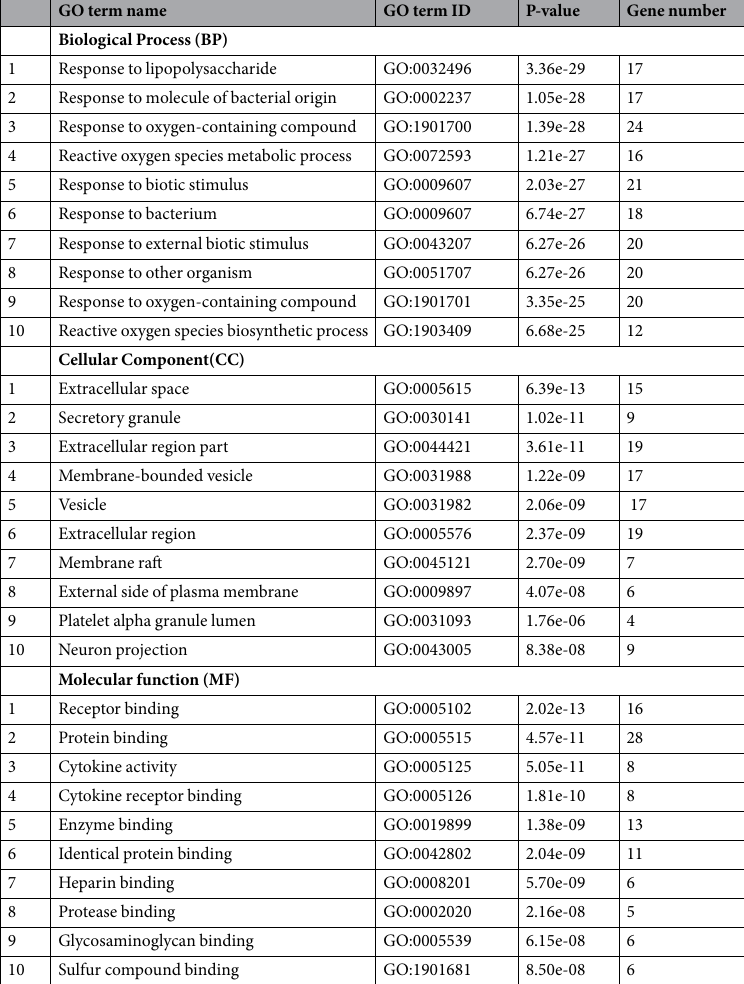
Table 3. Top 10 enriched gene ontology (GO) terms with genes associated with SCI (GAS30) for biological processes (BPs), cellular components (CCs), and molecular functions